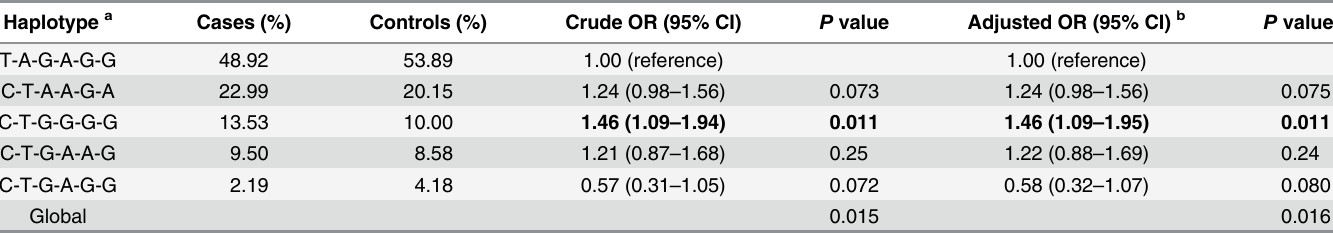
Table 6. Frequencies of derived haplotypes ( (cid:1) 1%) from six examined polymorphisms of RAC1 gene in cases and controls. Haplotype a Cases